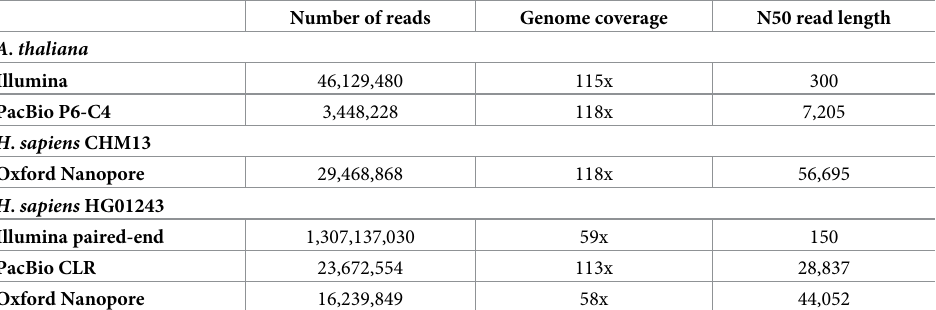
Table 1. Data used for the scaffolding experiments, including short and long reads from the model plant Arabi- dopsis thaliana , and reads from two different individual humans. The Illumina reads were paired-end reads of a fixed length. N50 read length is computed by summing all read lengths, and determining the value N50 such that 50% of that total length is covered by reads of N50 or